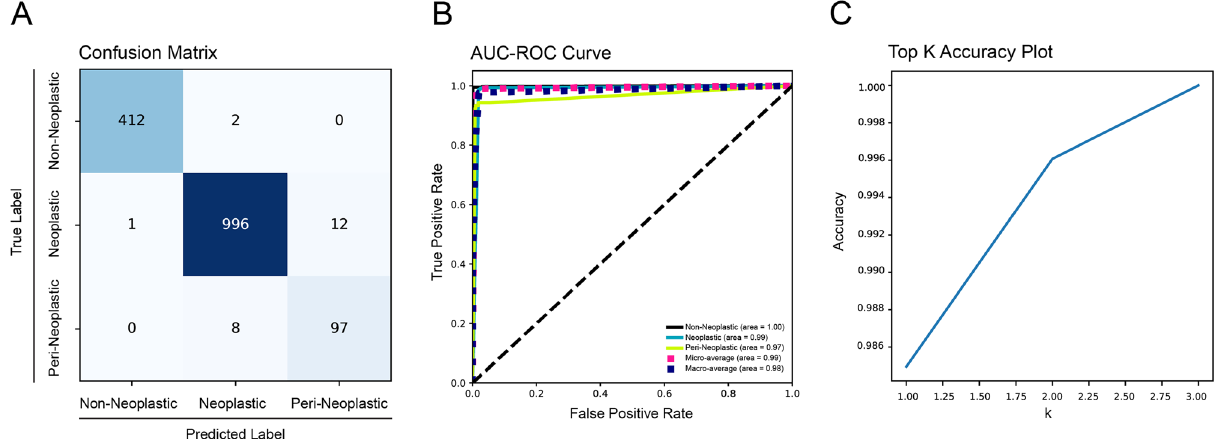
Figure 2. Performance of disease state classifier. ( A ) Confusion matrix of disease state classifier; ( B ) Receiver operating characteristic curve (ROC) with area under the curve (AUC); ( C ) top K accuracy plot.